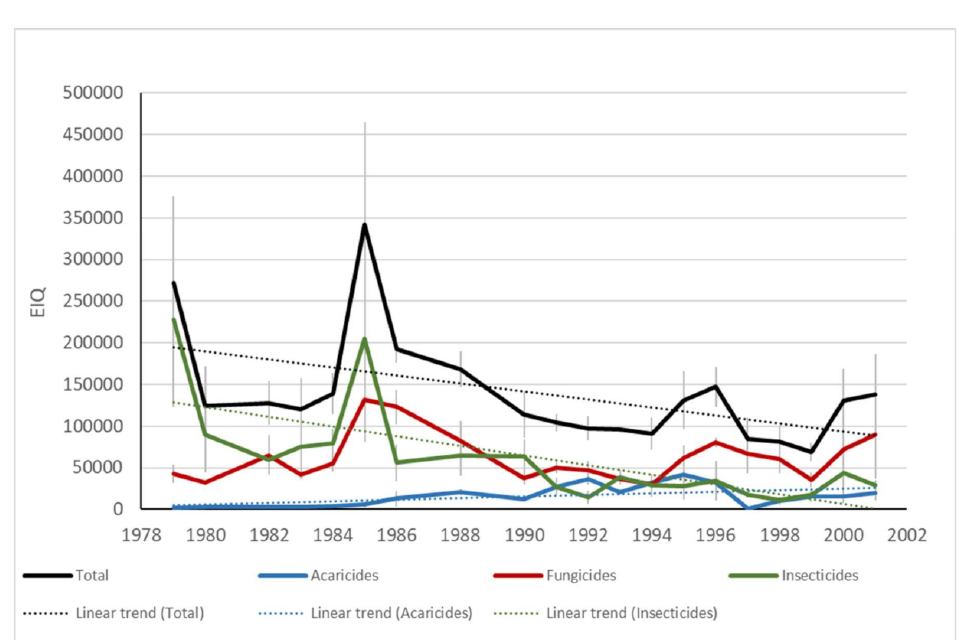
Figure 9. Impact of pesticides as expressed by the Environmental Impact Quotient (EIQ) and estimated annually from treatments applied in commercial orchards from 1979 to 2001. Orchards located at Hemmingford, Franklin and Oka. Vertical bars represent standard error. Only significant trends ( p < 0.05) are shown.